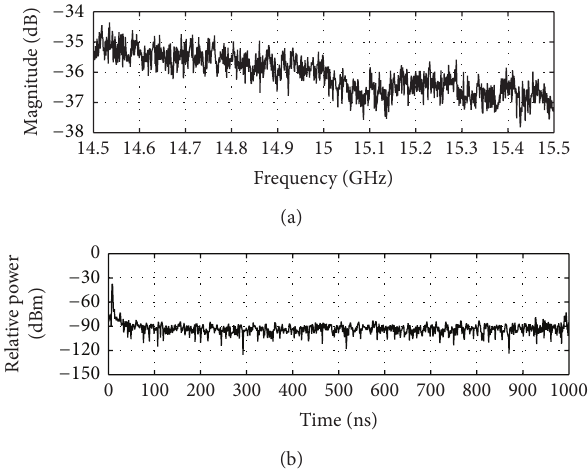
Figure 6: Snapshot received signal magnitude versus frequency domain (a) and time domain (b) of location 15 in corridor A.